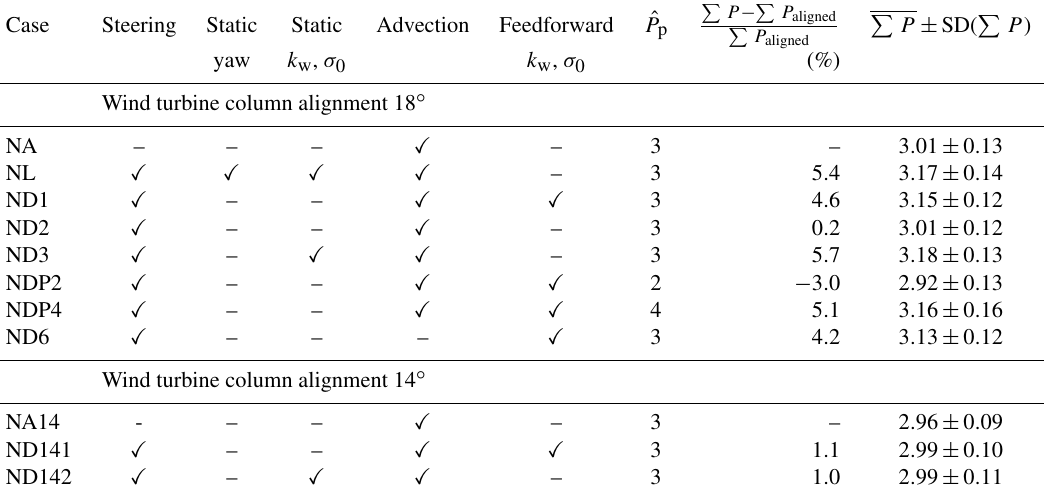
Table 1. The conventionally neutral finite wind farm wake steering cases. The mean power production increase with respect to yaw-aligned operation is calculated over approximately 24h of physical wind farm operation. Case NA is the yaw-aligned wind farm operation. Case NL approximates open-loop lookup-table-based control. Cases beginning with ND are dynamic, closed-loop control cases with various control architectures as denoted in the table. The wake model estimate for P p is ˆ P p .